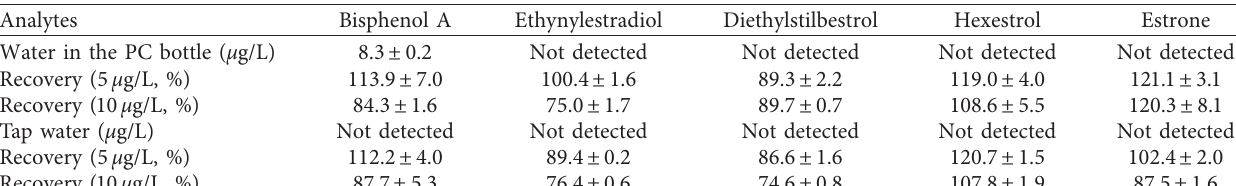
Table 4: Analytical results and recoveries of five estrogens in two real samples.